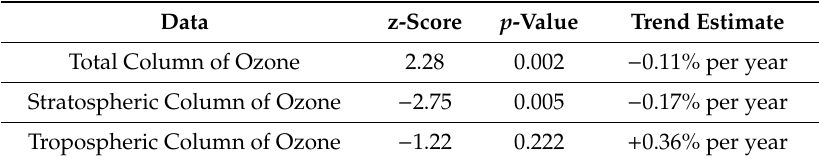
Table 4. Mann–Kendall statistics